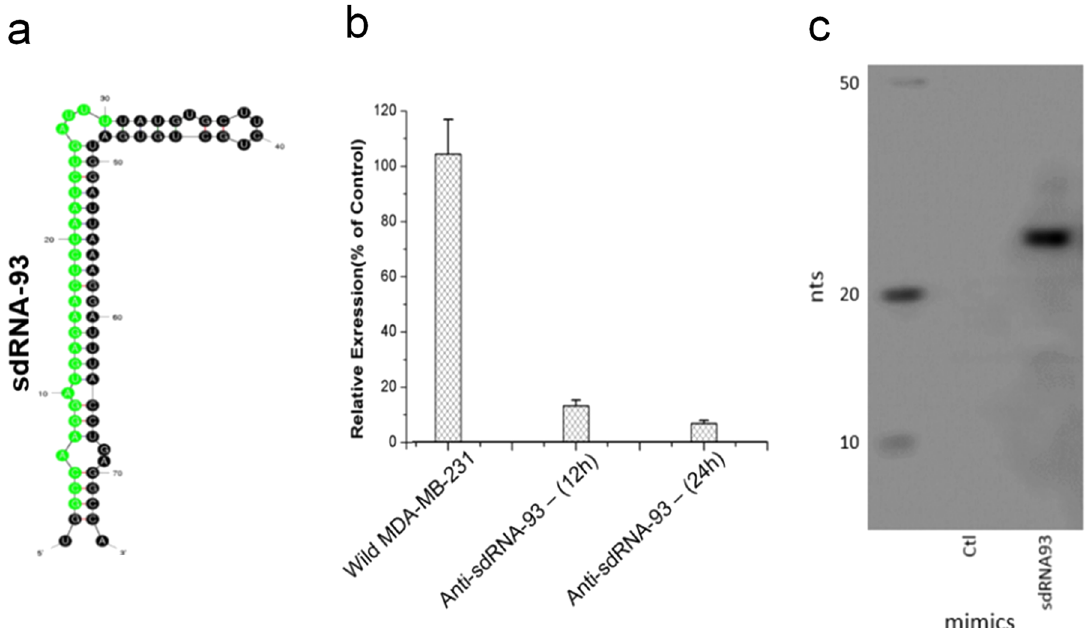
Fig. 2 Tools for manipulating sdRNA-93 expression. a The most thermodynamically stable secondary structure of snoRNA-93 as calculated by Mfold. 53 Predominately excised sdRNA-93 sequence is highlighted in green . b Knockdown of sdRNA-93 by transient transfection of MDA-MB- 231 cells with custom inhibitor (antisense to sdRNA-93) sequence depicted in green in a as determined by RT-qPCR ( n = 3). c Small transcript northern blot con fi rming the over expression of sdRNA-93 following transfection of MDA-MB-231 cells with custom mimic (identical to sdRNA- 93 sequence depicted in green in a vs. scrambled control